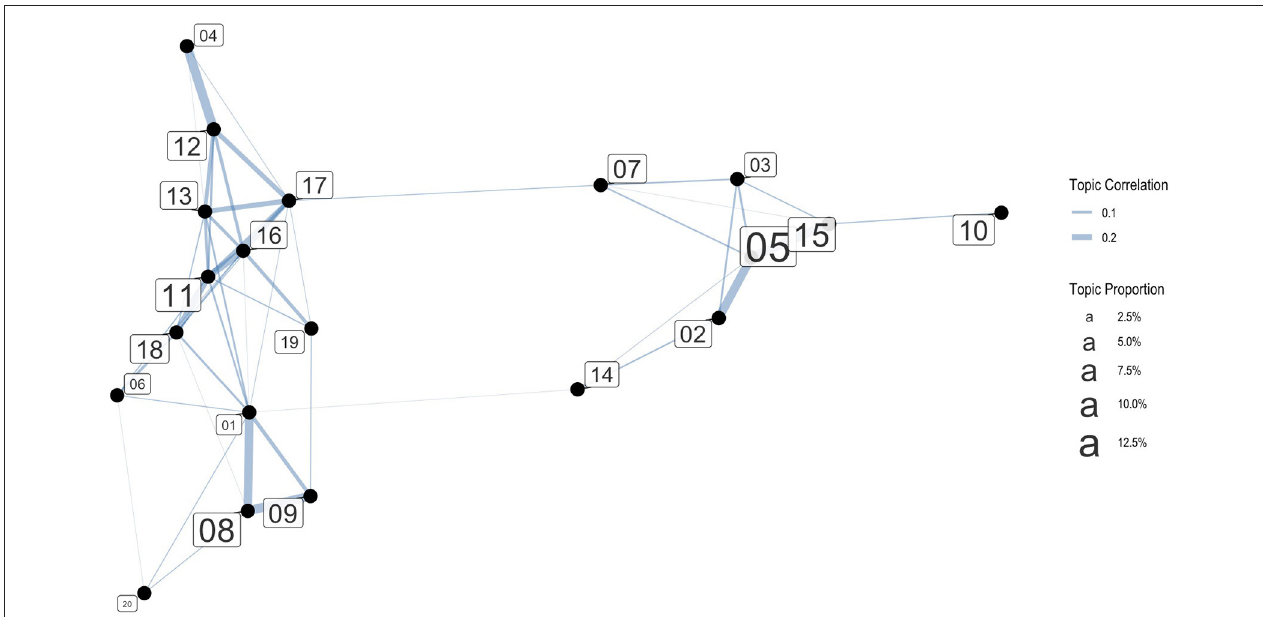
FIGURE 2 | Topic correlation graph (with tie strength > 0.01). The correlated topics are indicated as connections. The connected topics are likely to occur together in one